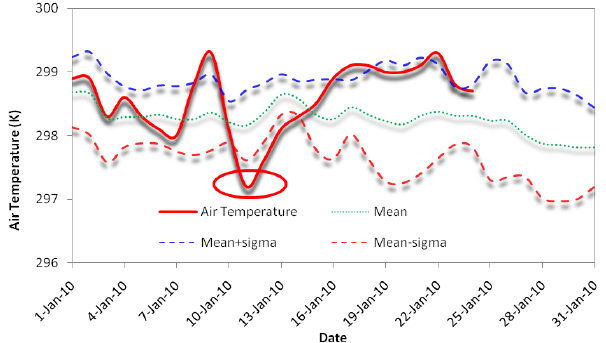
Fig. 2d. Figure 2d shows a minima peak of air temperature one day prior to the earthquake, this minima peak is found to be much temperature which is shown in dotted red color. The mean value is shown in dotted green lower than mean minus one sigma value of air temperature which is color. shown in dotted red color. The mean value is shown in dotted green